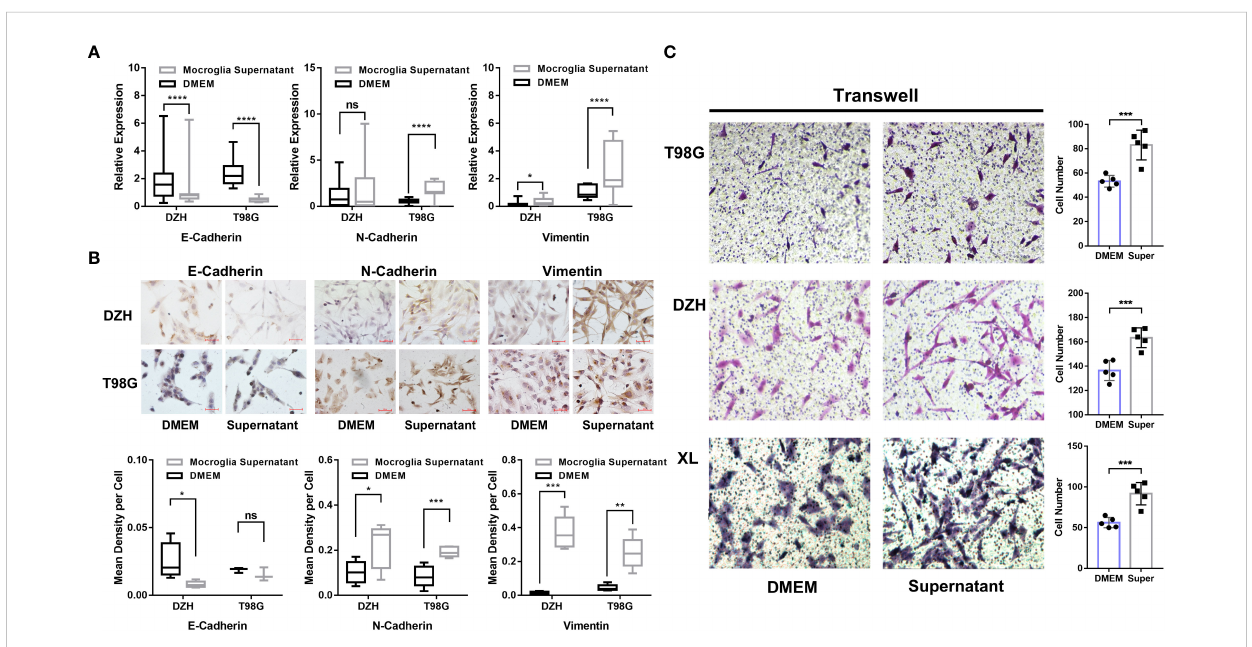
FIGURE 4 Investigation of GAMs ’ effect on the EMT process and invasion of glioma cells. (A, B) The glioma cell lines (DZH and T98G) were cultured with the supernatants of GAMs or DMEM media as a negative control for 12 hours. The expression of EMT markers in glioma cells was detected by q-PCR and immunocytochemistry (ICC). (A) The expression levels of E-Cadherin, N-Cadherin, and Vimentin were detected by q-PCR. (B) Representative ICC detection of E-Cadherin, N-Cadherin, and Vimentin in glioma cells, and the corresponding statistical graphs were shown in the bottom row. (C) The effect of GAMs ’ supernatant on the invasion capacity of three glioma cell lines (T98G, DZH, and XL) was investigated by transwell assay (DMEM as control). The representative transwell images of different glioma cell lines (left) and corresponding statistical graphs (right) were shown. (* for p-value<0.05, ** for p-value< 0.01, and *** for p-value< 0.001).